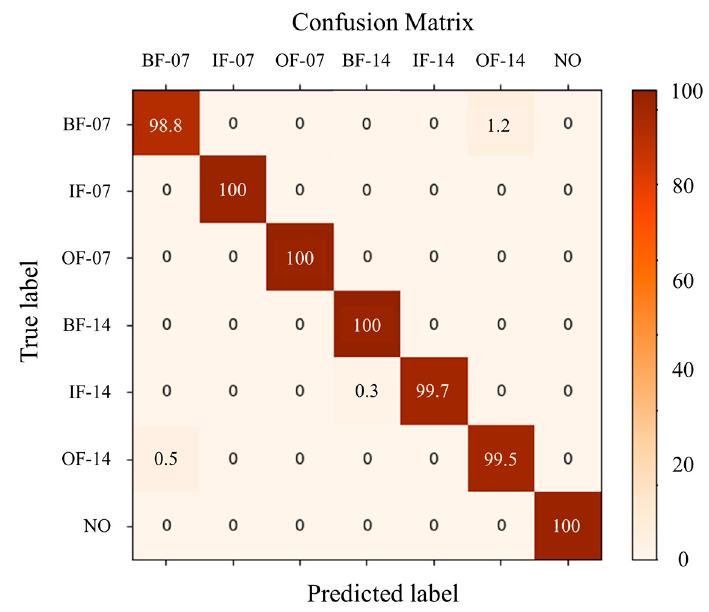
Figure 11. The precision, recall, and F1 score for T 01 , T 12 and T 23 .